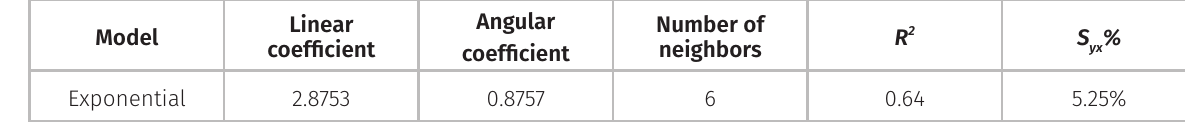
Figure 7. Thematic map of site classification based on ordinary kriging for Eucalyptus sp. in a tropical region of